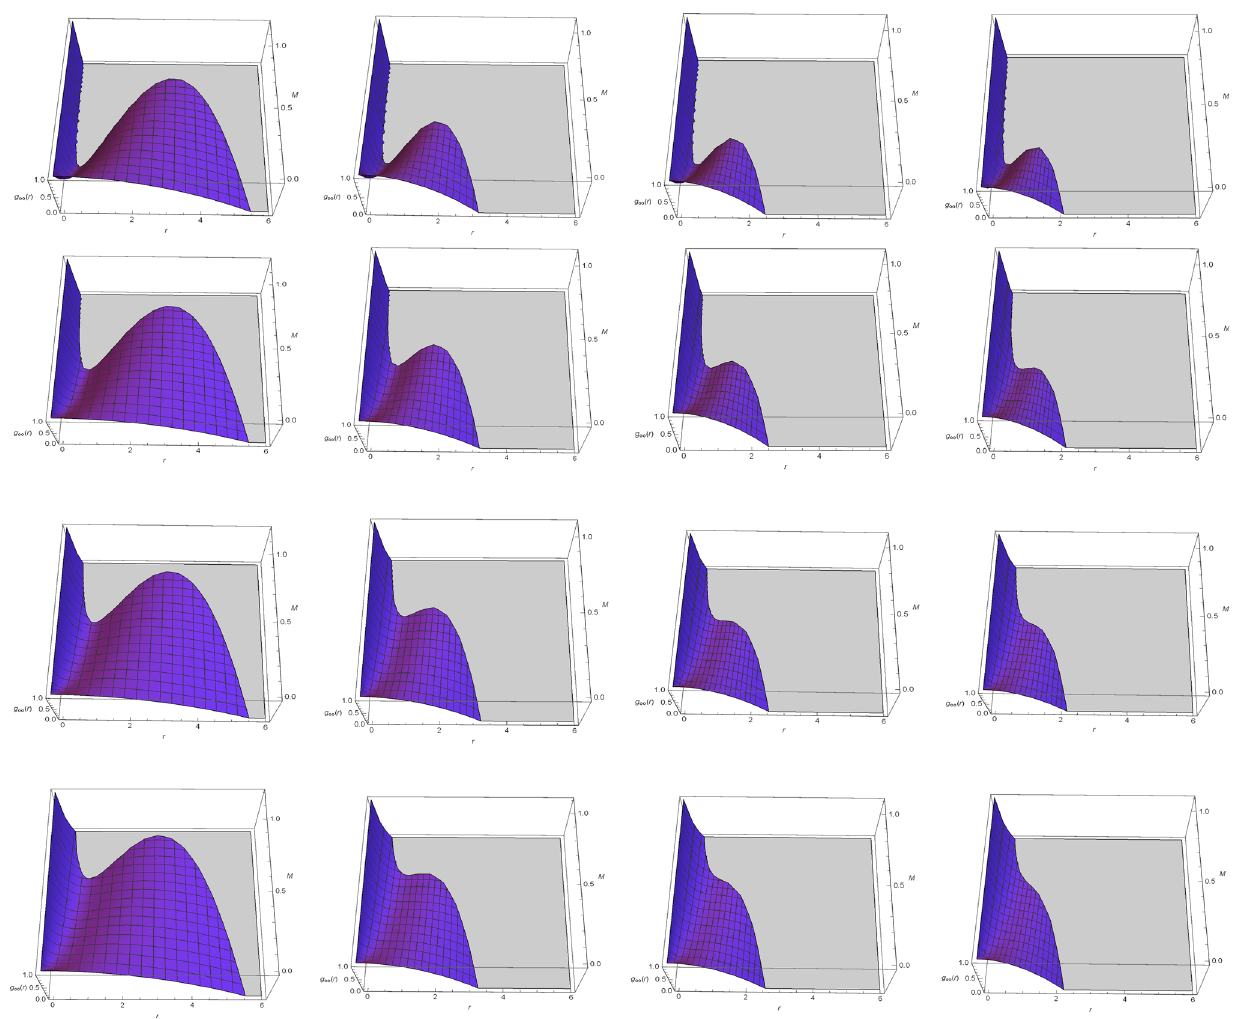
Fig. 2 g 00 ( r ) versus of M and r with different α and (cid:5) for asymp- totically dS EGB black hole. Plots have been depicted with α = 0 . 1 , 0 . 3 , 0 . 5 , 0 . 7 from up to down and (cid:5) = 0 . 1 , 0 . 3 , 0 . 5 , 0 . 7 from left to right. As regards each row, as (cid:5) increases, the M cri 2 decreases and